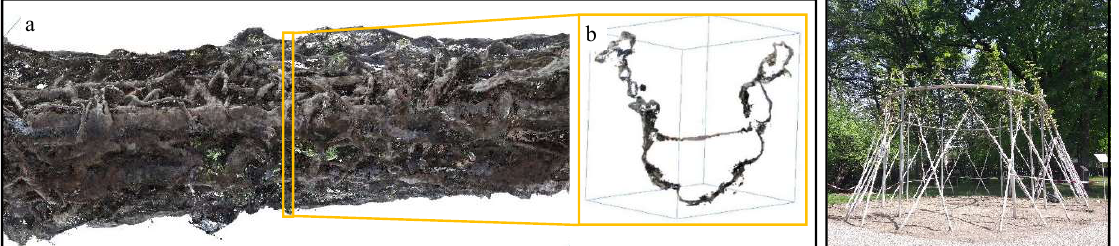
Figure 7: Comparing the underside (a) with through-sections (b) an understanding of the bridge’s topology can be gained.